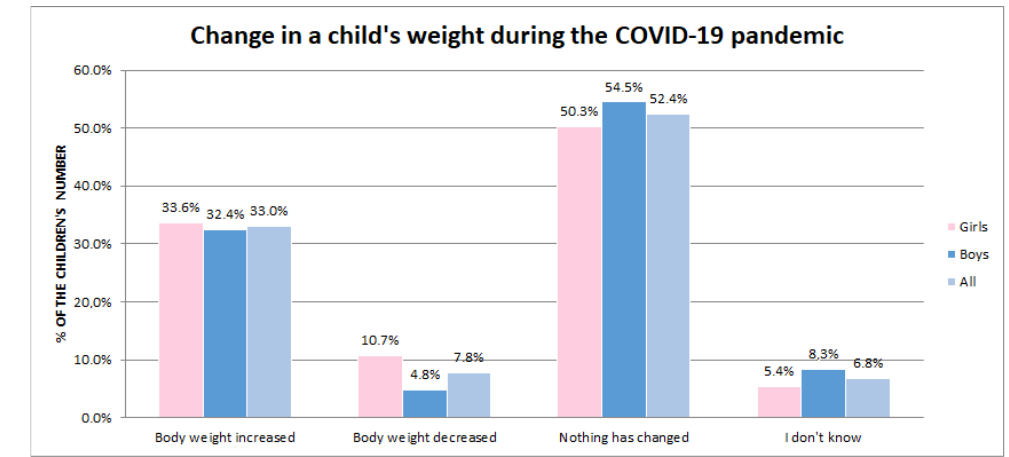
Figure 2. Change in the body weight of the studied children during the COVID-19 pandemic.